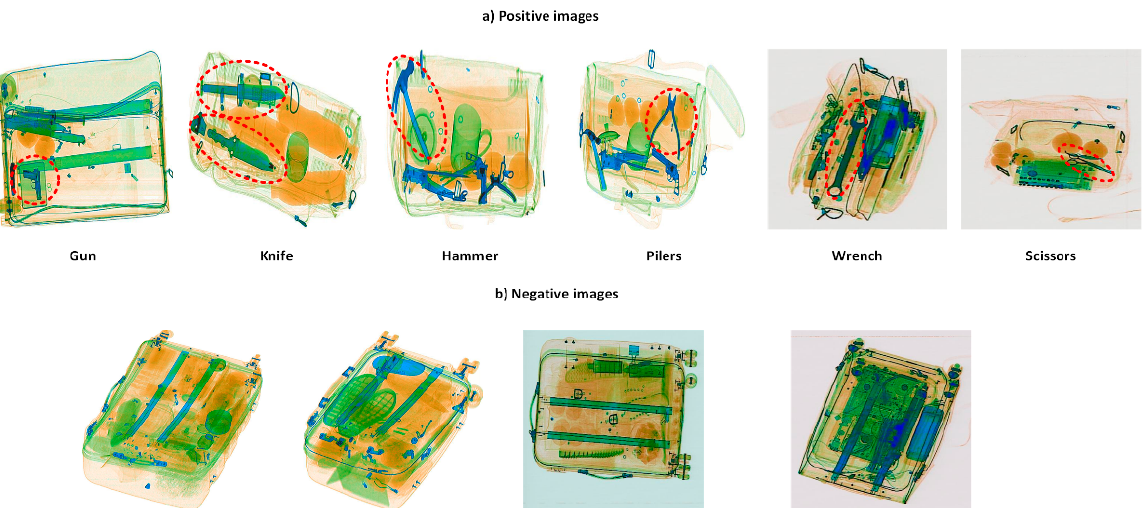
Figure 4. Example images of the ( a ) positive and ( b ) negative images from the SIXray dataset. Positive images contain at least one of the prohibited objects, whereas negative images do not contain any prohibited objects. Table 4. Comparison of the colorization performance of the artificial image and raw-image-based models on the COMPASS-XP dataset in terms of PSNR, SSIM, and LPIPS. Input Image.